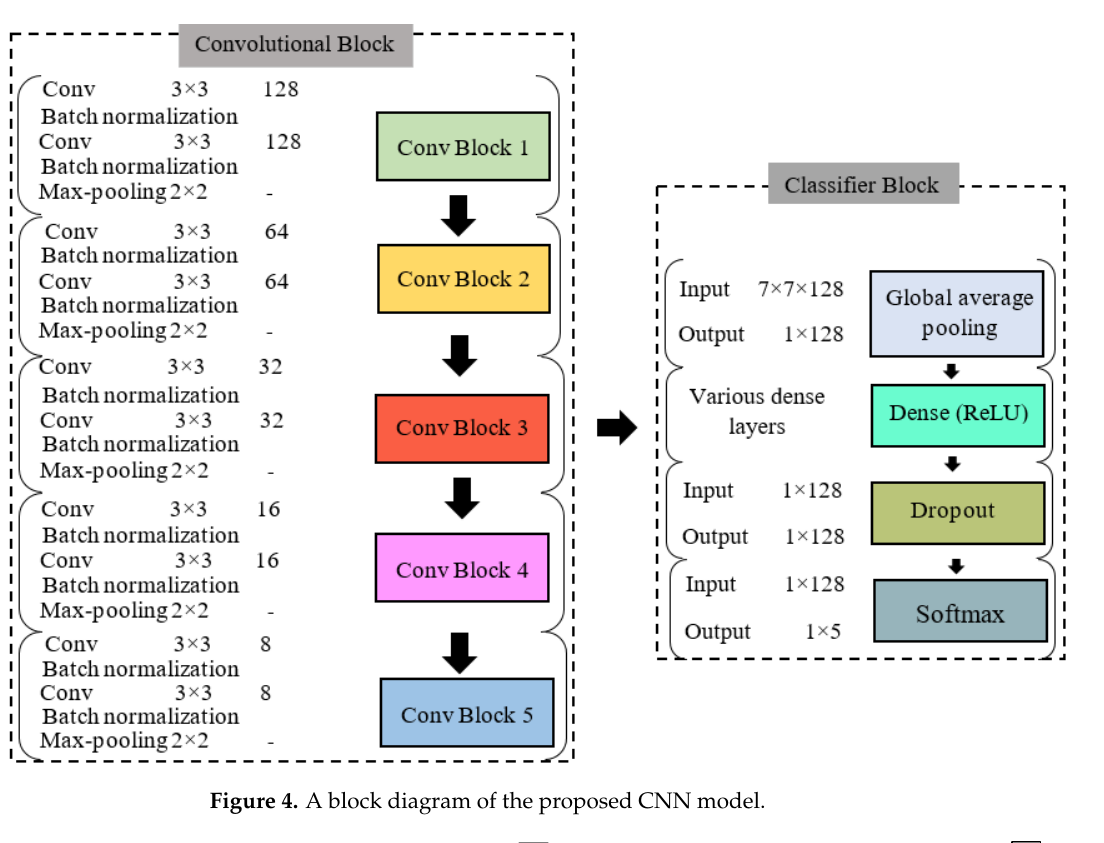
Figure 4. A block diagram of the proposed CNN model.